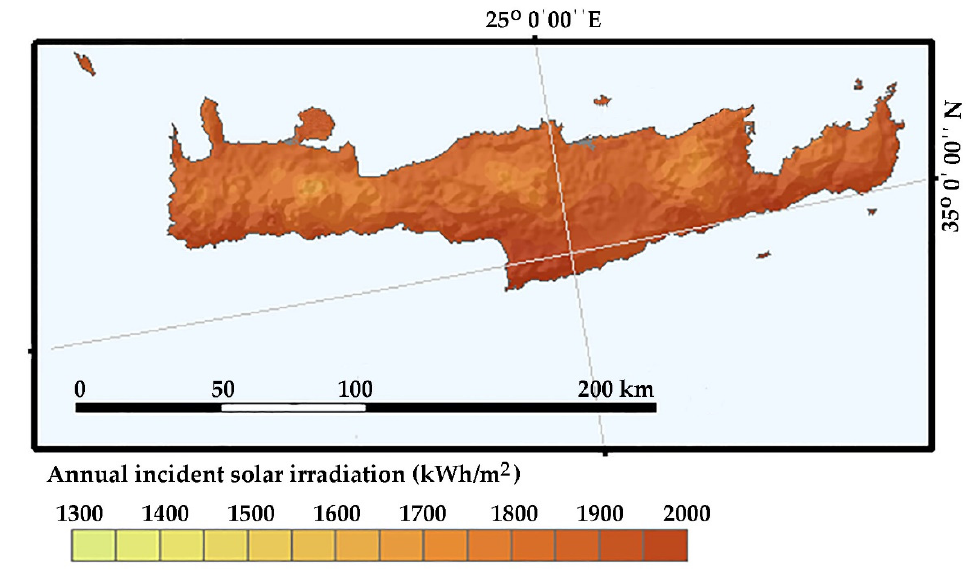
Figure 1. Yearly sum of global irradiation on the horizontal plane in Crete [42].